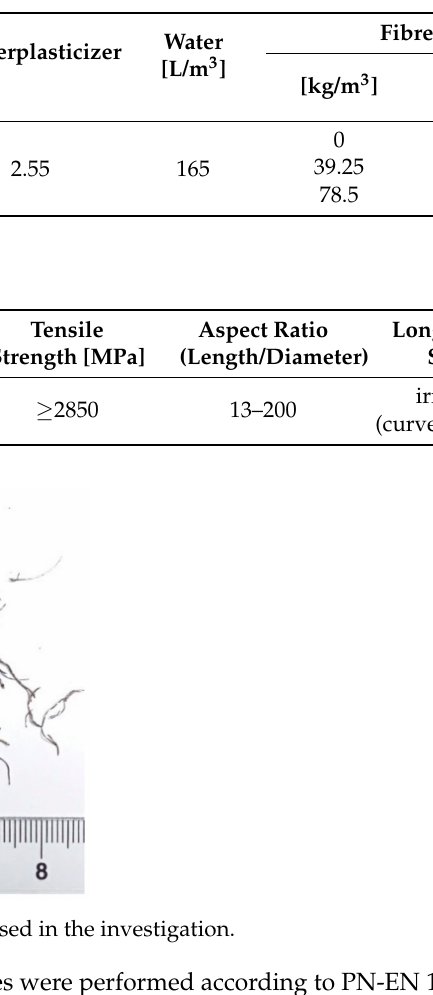
Table 1. Composition of concrete mix.